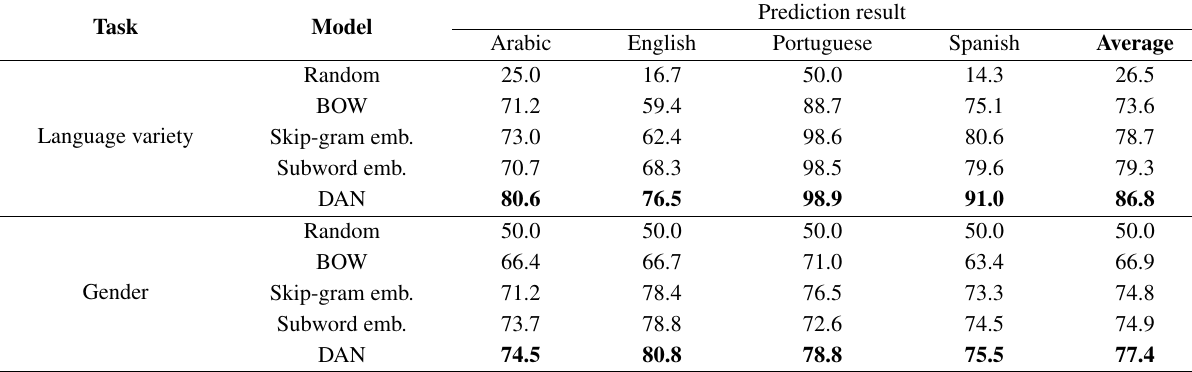
Table 13 Prediction results obtained using multiple models by Franco-Salvador et al. [49]